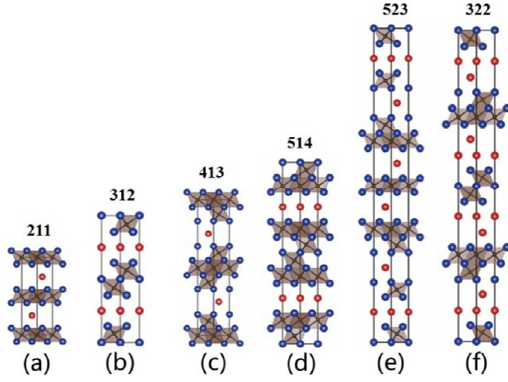
Fig. 2 Illustration of the unit cell projected long (110). Blue, red, and black balls denote the M, A, and X atoms, respectively. Reproduced with permission from Ref.